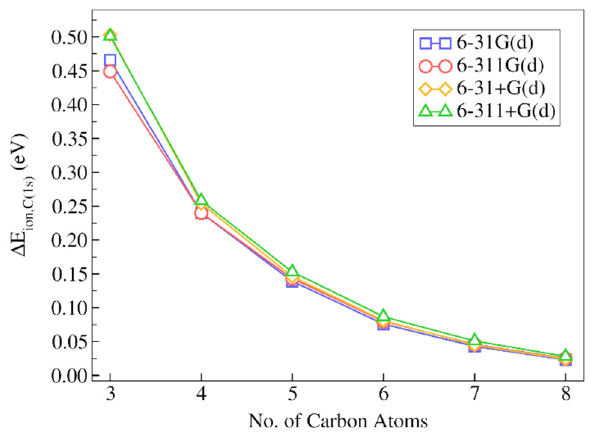
Figure 6. Absolute deviations of the IMOM/ELMO 1s core-ionization energies for the carbonyl carbon atom of 2-decanone from the reference fully IMOM values ( ∆ E ion,C ( 1s ) ), as a function of the number of carbon atoms gradually included in the quantum mechanical region of the QM/ELMO calculations. Only the results of the computations performed with the PBE0 functional are reported. Table 2. Relative discrepancies (in %) of the IMOM/ELMO 1s core-ionization energies for the carbonyl carbon atom of 2-decanone with respect to the reference fully IMOM values, as a function of the number of carbon atoms progressively included in the quantum mechanical subsystem of the performed QM/ELMO computations. Only the results of the calculations performed with the PBE0 functional are reported.